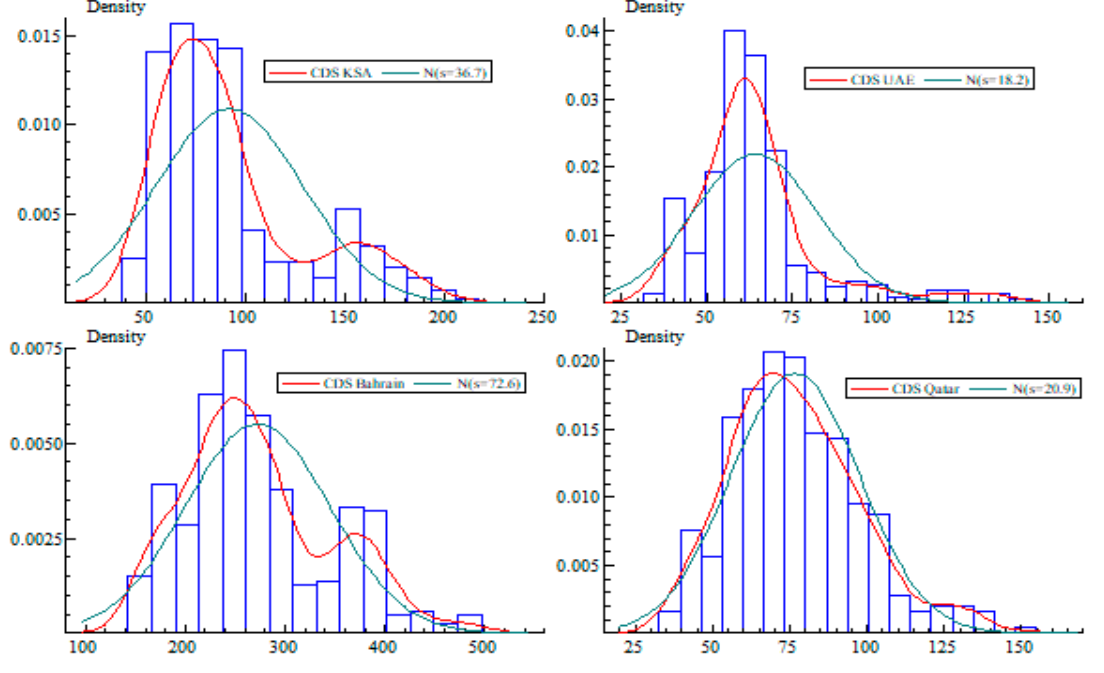
Figure 4. The non-normality of the SCDS spreads.